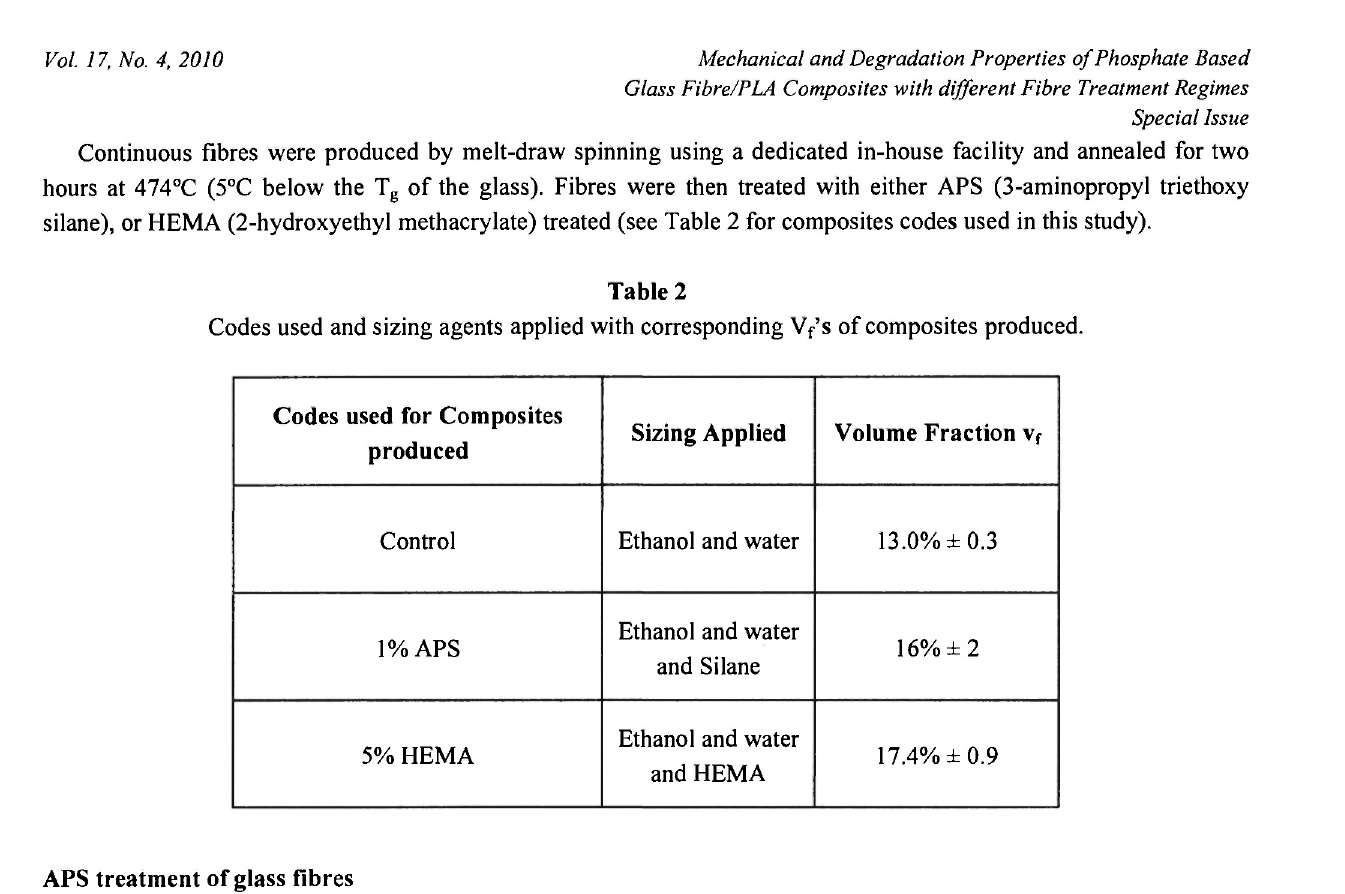
Codes used and sizing agents applied with corresponding V f 's of composites